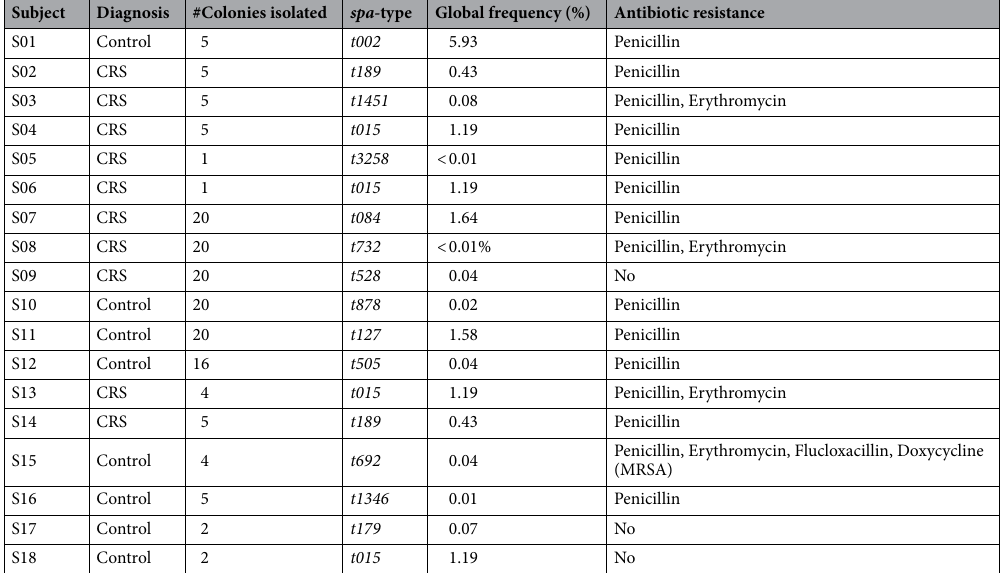
Table 2. Characteristics of the Staphylococcus aureus isolates recovered in this study for chronic rhinosinusitis (n = 10) and disease control (n = 8) patients. Staphylococcal protein A ( spa ) typing results and reported relative global frequency distributions were determined using Ridom StaphType software v2.2.1. Isolates were considered methicillin-resistant S. aureus (MRSA) if they exhibited resistance to penicillin and flucloxacillin antibiotics. CRS chronic